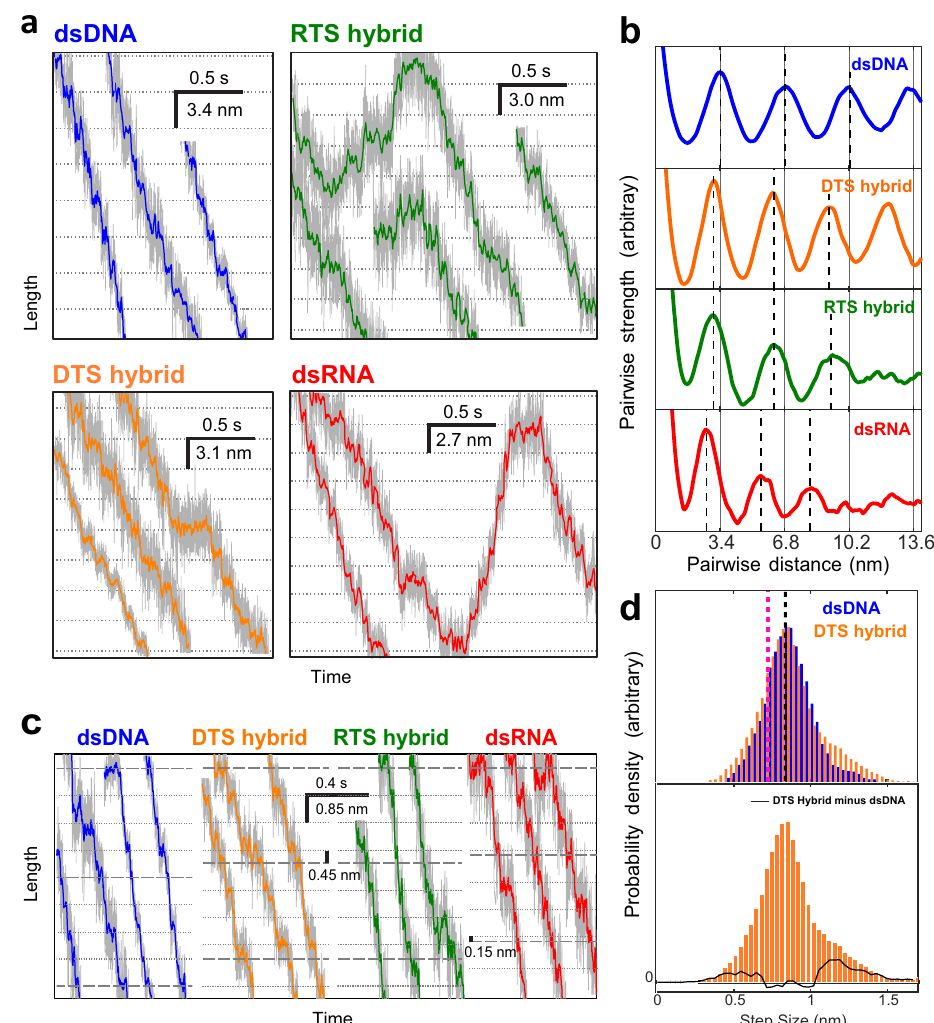
Fig. 2 Burst and step sizes for different substrates. a Representative packaging traces at low force (7 – 12 pN) are shown for the four substrates at 2.5 kHz (gray) and are fi ltered to 100 Hz (colored). On A-form substrates, the dwell-burst coordination of the motor is retained but with a changed burst size. The dashed lines are spaced to match the mean burst size of the substrates. b Pairwise distance analysis of the trajectories con fi rms a decrease of the burst size for the three A-form substrates. The dashed lines are evenly spaced in multiples of the mean burst size. c Representative traces at high force (35 – 40 pN) resolves motor steps. For dsDNA, steps of 0.85 nm are observed; however, for A-form substrates, smaller steps are also seen every four steps. d Step-size distributions from packaging traces against high-force. Top: the step-size distribution of dsDNA and DTS hybrid peak at 0.85 nm (black dashed line). The striking similarity between maxima supports the interpretation that the burst adapts to the decreased helical pitch by modifying one of the four steps over the alternative model where the four steps are proportionally reduced. Would the latter be the case, the DTS hybrid step distribution would be expected to peak at 0.72 nm (magenta dashed line). Bottom: by taking the difference between the dsDNA and the DTS hybrid step-size distributions (black solid line), we observe two populations of steps whose means are 0.51 and 1.36 nm, respectively. These sizes are consistent with the size of the expected fourth reduced step and its combination with one regular 0.85 step, as if the two steps were combined during step fi nding. For all panels, [ATP] is 0.25